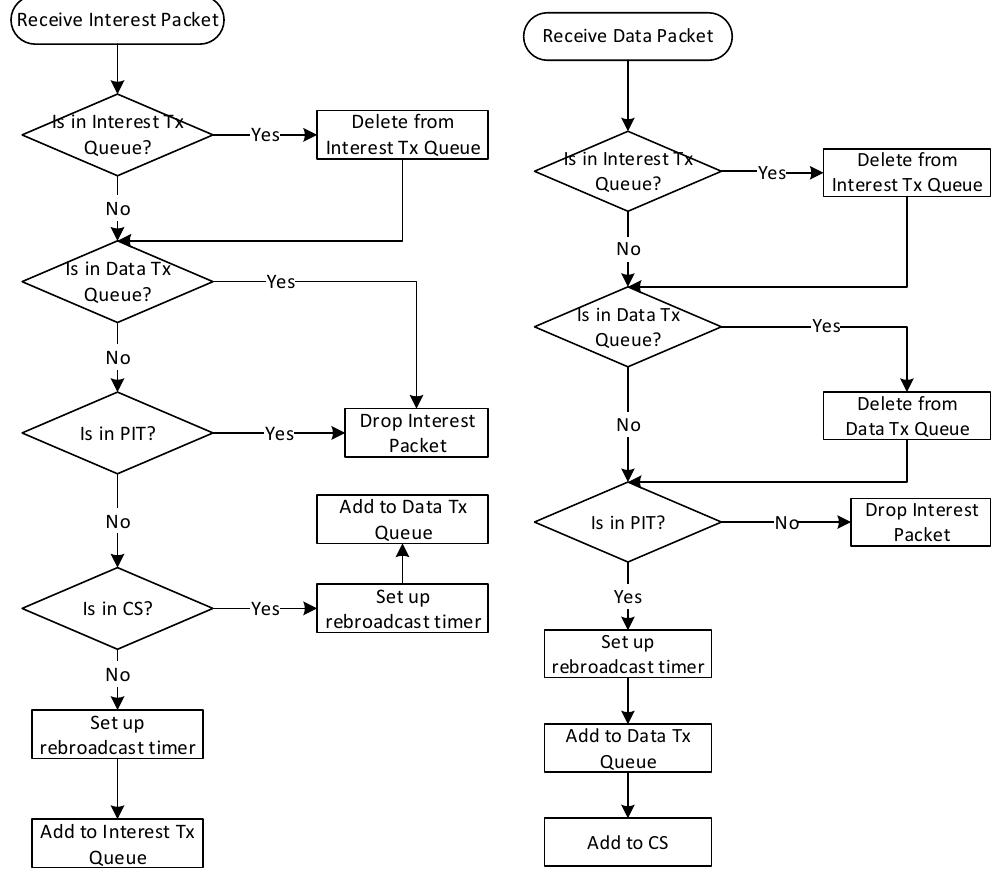
Figure 4. Interest and Data Forwarding